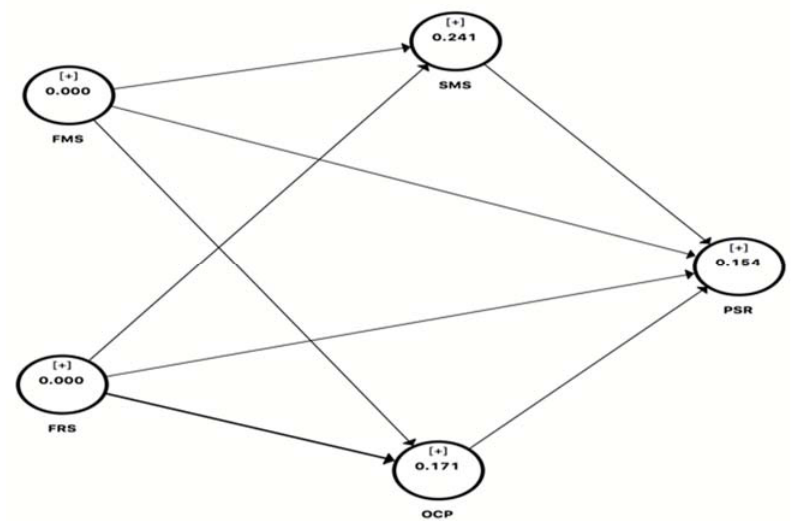
Figure 2. Cross-validity redundancy analysis. Figure 2. Cross ‐ validity redundancy analysis. Table 5. PLS predict.